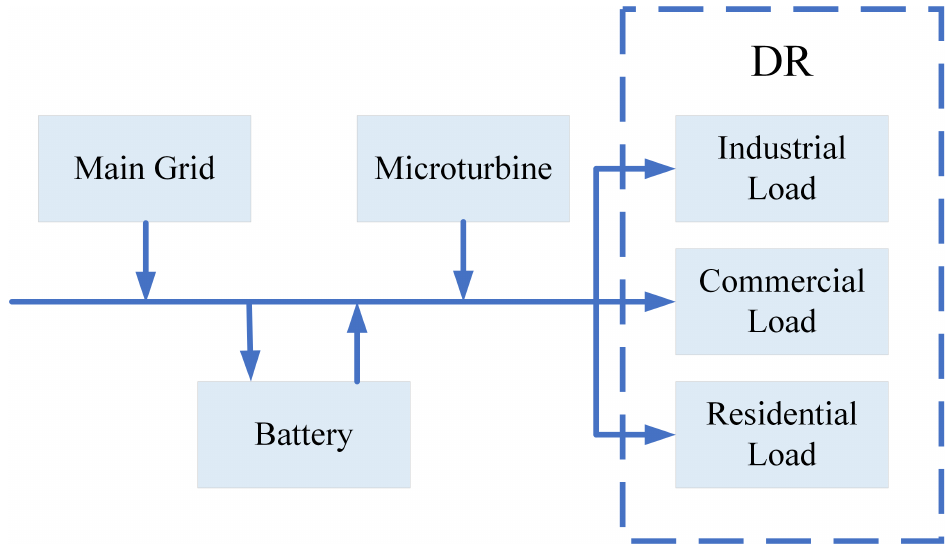
Figure 1. Structure of